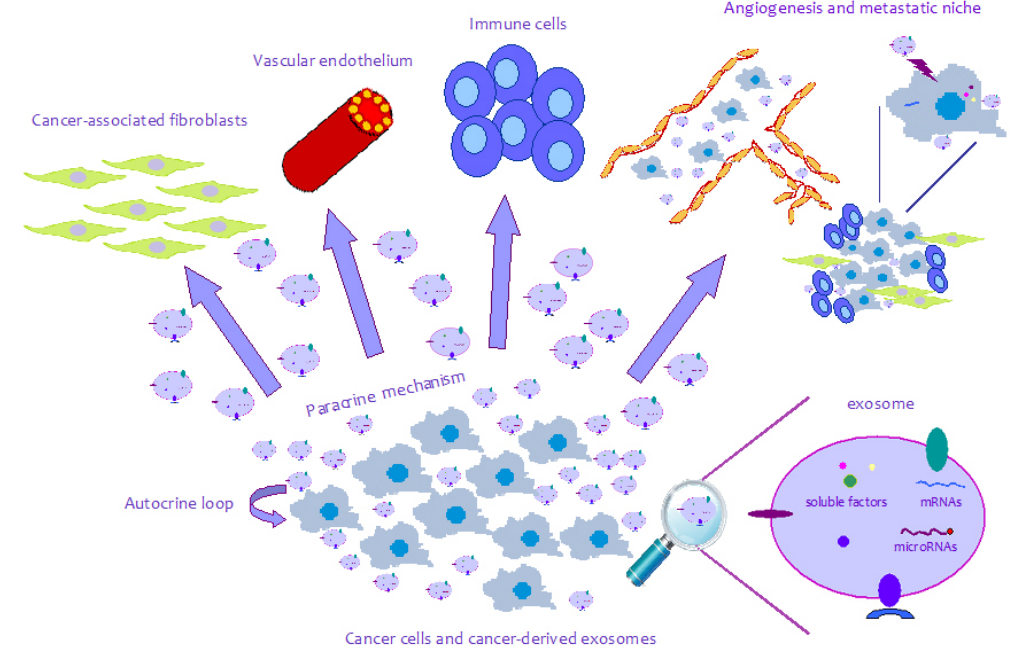
Figure 1. Schematic representation of exosome-mediated crosstalk. Tumor and normal stroma cells communicate through exosomes to establish a favourable tumor microenvironment and promote cancer growth, invasion and metastasis. Exosomes contain soluble factors, mRNA and miRNAs that may affect the phenotypes of different cytotypes such as fibroblasts, vascular endothelial cells and immune